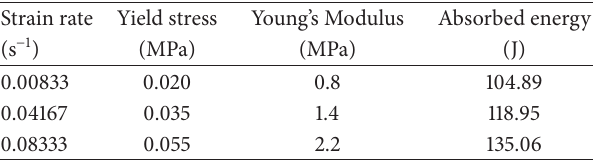
Figure 2: Rate dependency of EPS crushable foam. Table 1: Effects of strain rate on yield stress, Young’s Modulus, and absorbed